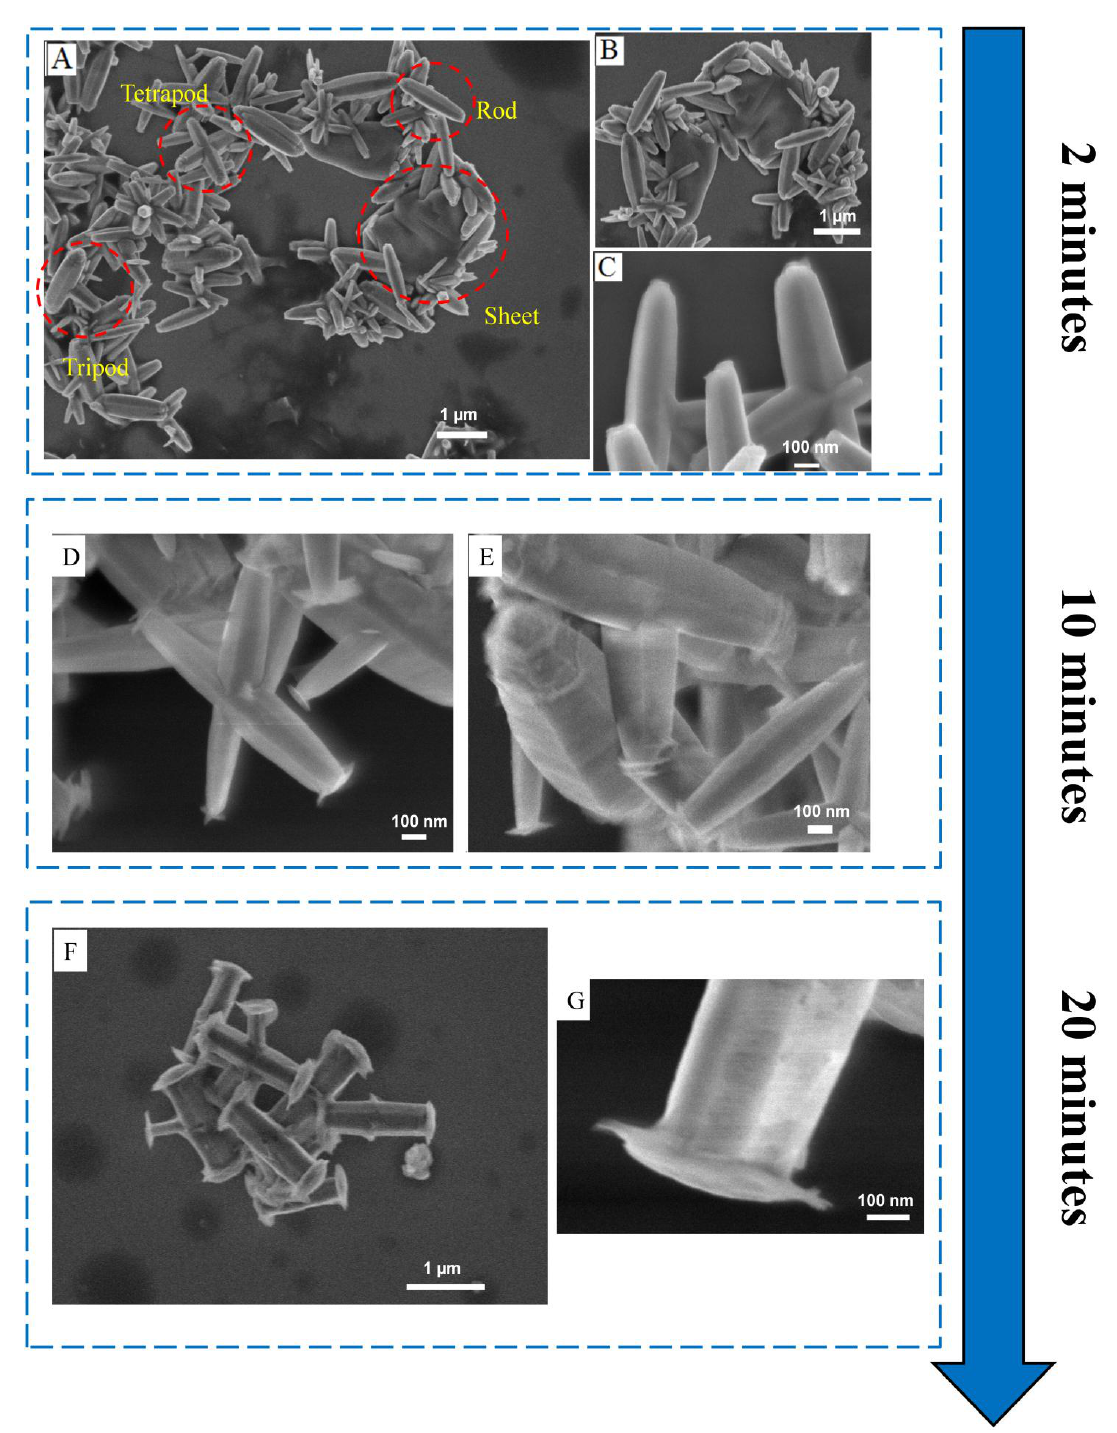
Figure 1. SEM images of ZnO microstructures formed by heating 25 mM of an equimolar mixture of HMT:Zn 2+ at 170 °C, for various times, in a microwave-assisted